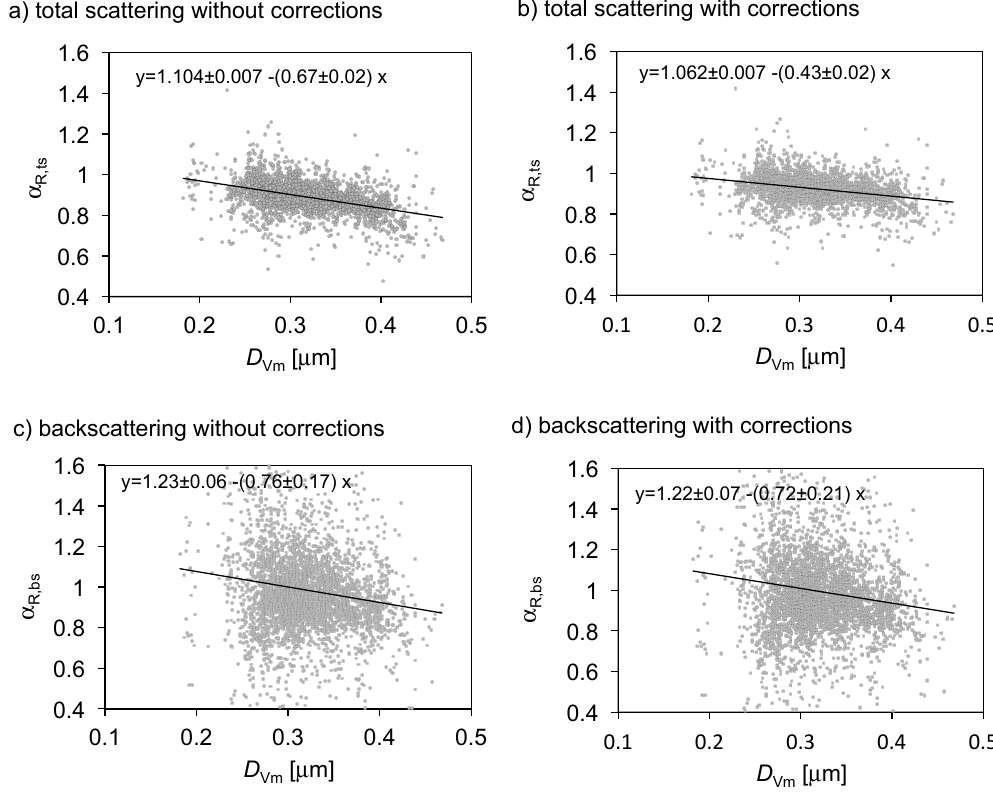
Fig. 9. Results from ambient air experiments. Ratios of ˚Angstr¨om exponents ( α R ) at wavelength 450 and 525nm, defined by ˚Angstr¨om exponents from the Aurora 3000 divided by ˚Angstr¨om exponents from the TSI 3563. Panel (a) and (b) show ratios for uncorrected and sensitivity corrected total scattering. Ratios for uncorrected and sensitivity corrected backscattering are shown in panels (c) and (d)